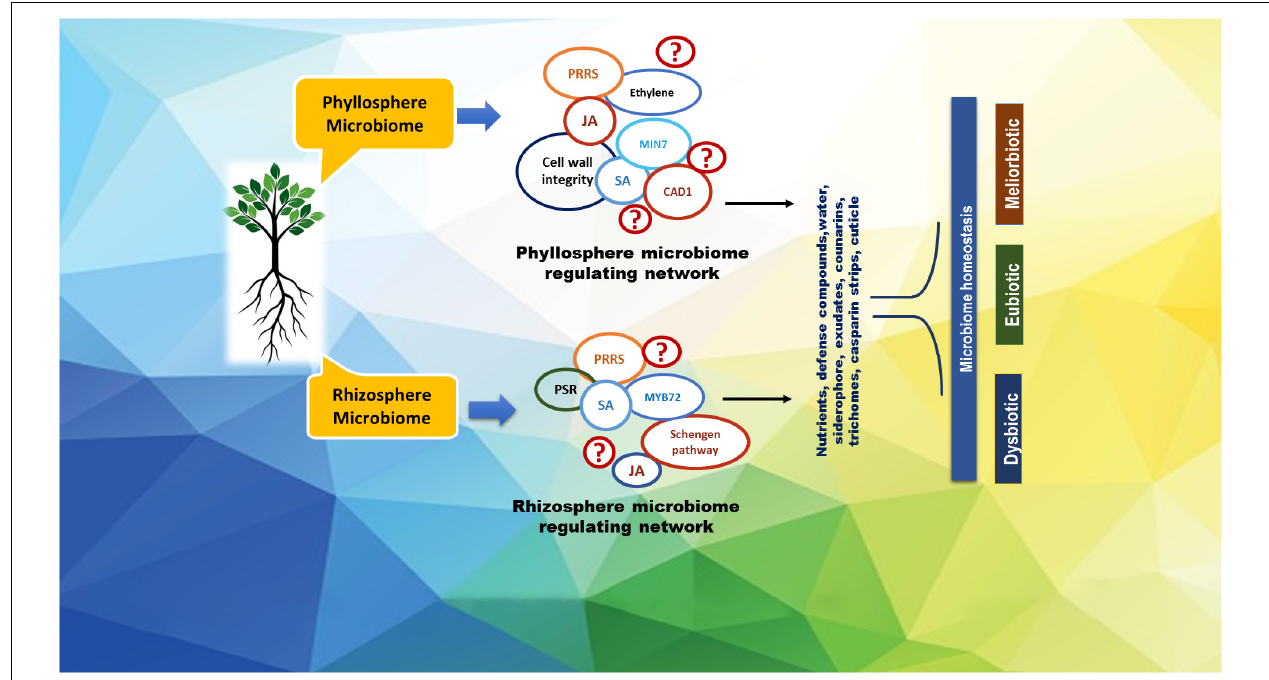
FIGURE 1 | A representative roadmap of the regulation of citrus microbiome in plant homeostasis. Some of the known regulators of the plant host involved in microbiome homeostasis are depicted in the figure as CAD1, constitutively activated cell death 1; JA, jasmonic acid; MIN7, HOPM1-interactor 7; MYB72, MYB domain protein 72; PRRs, pattern recognition receptors; PSR, phosphate starvation response; SA, salicylic